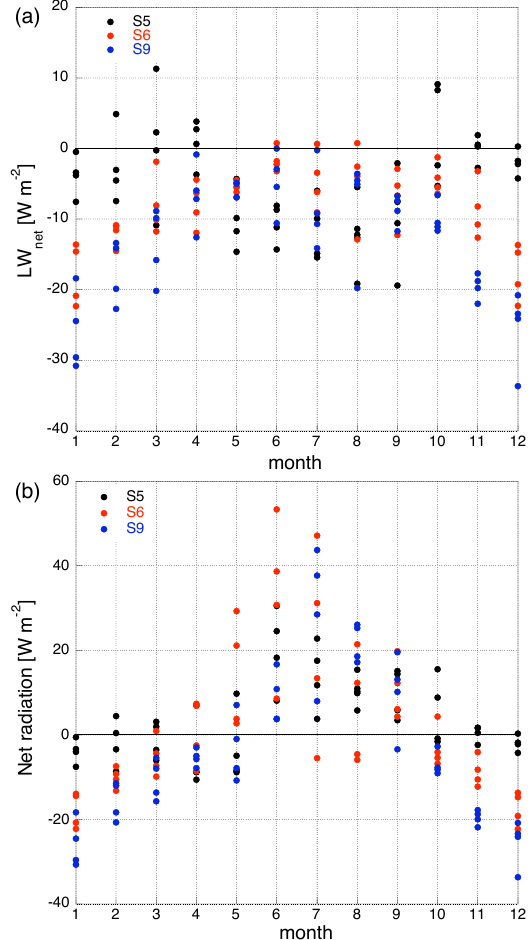
(about +20 W m − 2 ), while at S5 and S9 the biases ( − 4.9 and +4.1 W m − 2 , respectively) are much smaller.